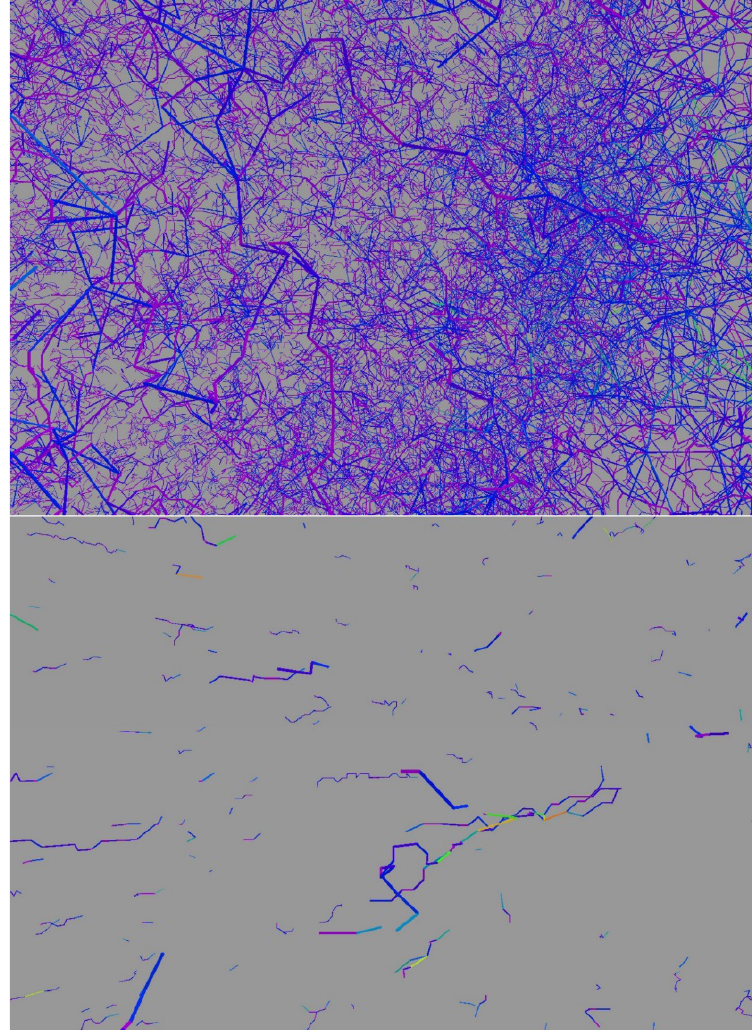
Figure 16. Dense graphs of pores, with pores not shown, only the connections/throats that join them. ( Upper ), ceramic 1 (27.6 vol.% pores); ( lower ), ceramic 11 (1.99 vol.% pores). Connections are color-coded by Euclidean length. The many connections for ceramic 1 are all on the shorter end of the spectrum (purple, blue, and a few green) whereas the connections in ceramic 11 have more variation and range up to yellow and orange on the longer end of the spectrum. Ceramic 1 also shows more tortuosity (winding rather than direct connections) than ceramic